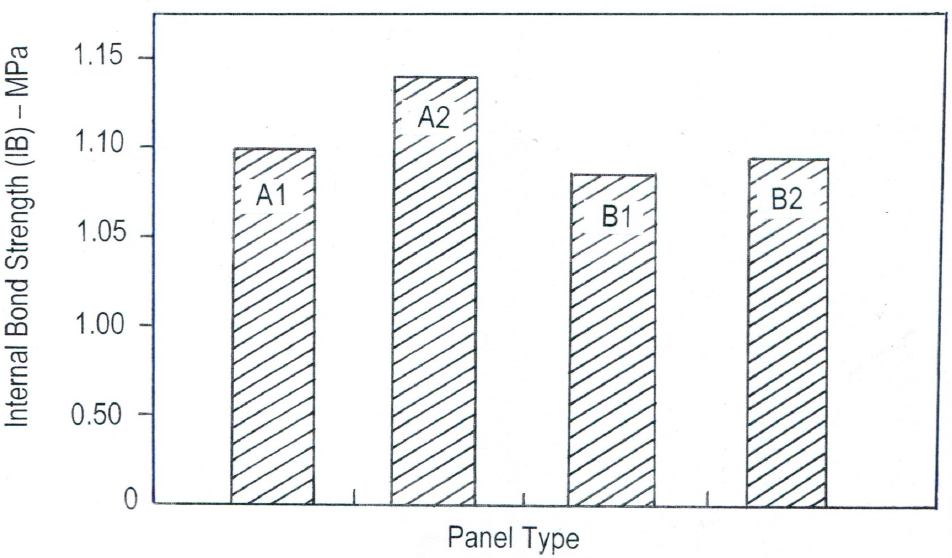
Figure 4. Internal bond strength values of the